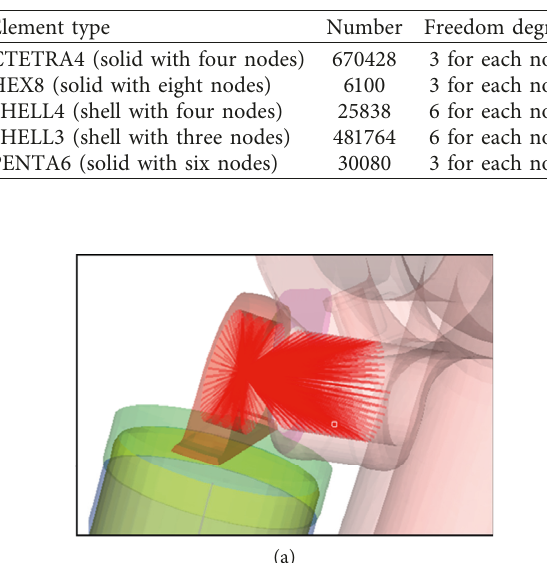
Table 5: Element types used in full-FE dynamic model.